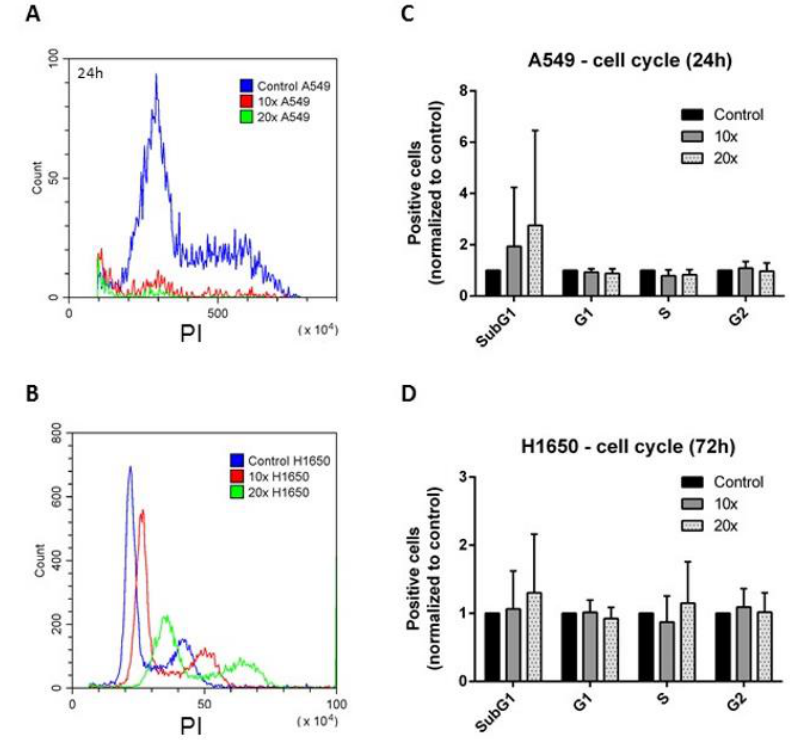
Figure 2. Cell cycle analysis of A549 and H1650 lung cancer cells. ( A ). Results of the cell cycle analysis of A549 by flow cytometry. ( B ). Results of the cell cycle analysis of H1650 by flow cytometry. C. Results of the statistical analysis of the cell cycle measurements of A549 cells ( n = 4). D. Results of the statistical analysis of the cell cycle measurements of H1650 cells ( n = 5). Only a tendency of increased SubG1 fractions were seen in A549 cells after 24 h ( A , C ) and in H1650 cells after 72 h ( B , D ) treatments ( p = 0.35 and p = 0.46, respectively). × 10 and × 20: concentrations of methyl-do- nors.